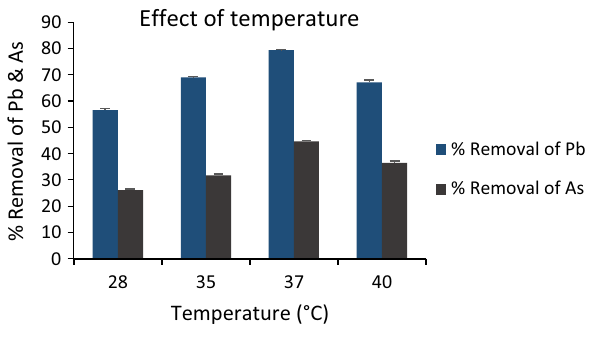
Fig. 9 Effect of temperature on adsorption of Pb and As. Experimen- tal conditions: adsorbent dose 3 g/100 ml, pH 4.0 (Pb) and 2.0 (As), contact time 60 min. Values are mean ± SE, n = 3 Table 2 Langmuir and Heavy metals T (°C) Freundlich constants for adsorption of Pb and As ions on soya bean adsorbent